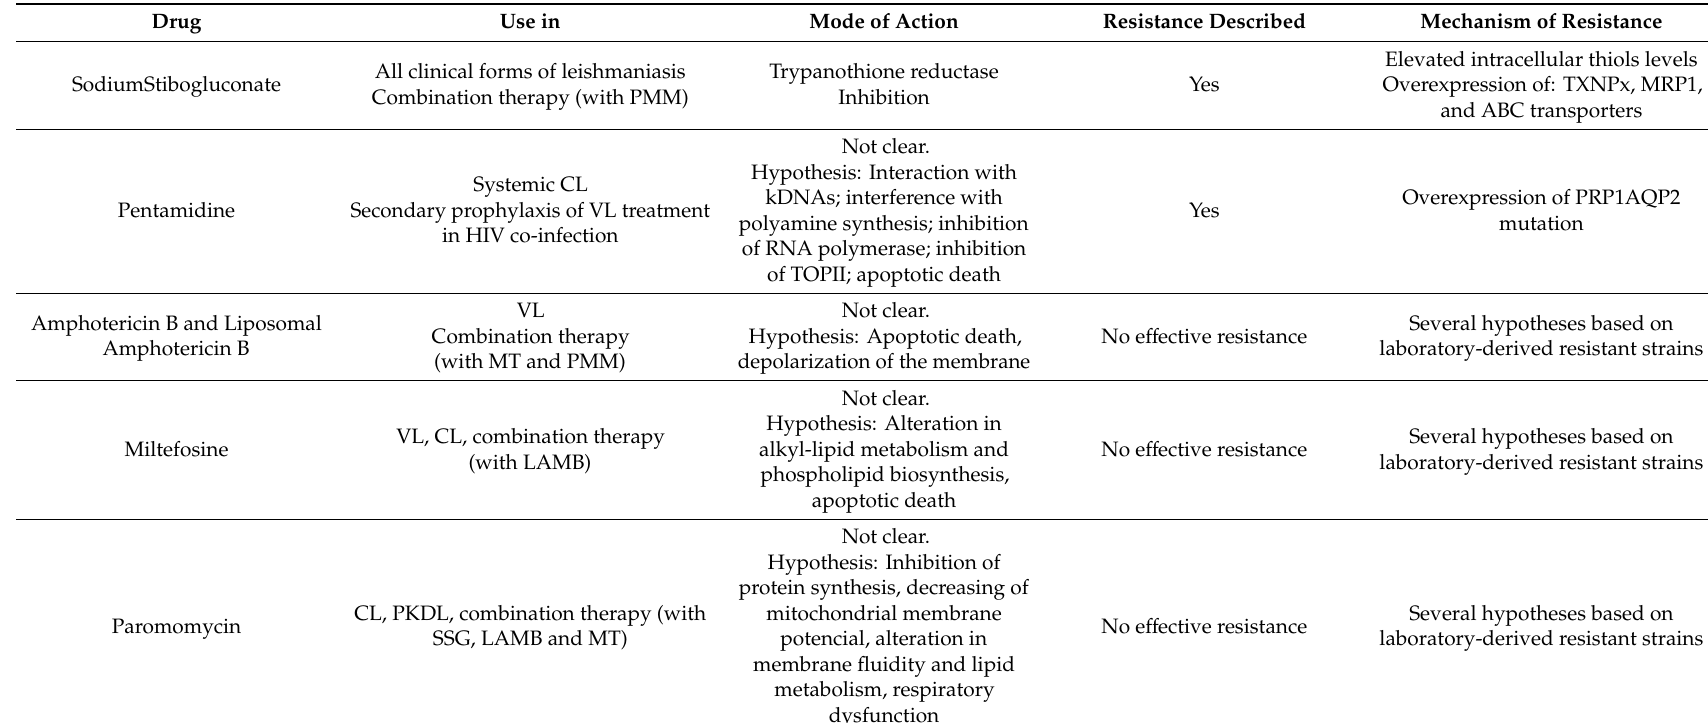
Table 2. Antileishmanial drugs, their uses, and mechanisms of